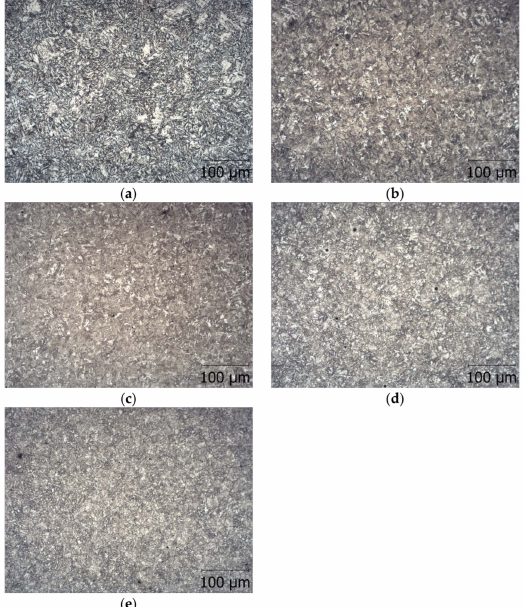
Figure 3. Microstructure of researched steel hardened at 880 ◦ C, and tempered ( a ) at 200 ◦ C, ( b ) at 300 ◦ C, ( c ) at 400 ◦ C, ( d ) at 500 ◦ C, and ( e ) at 600 ◦ C.